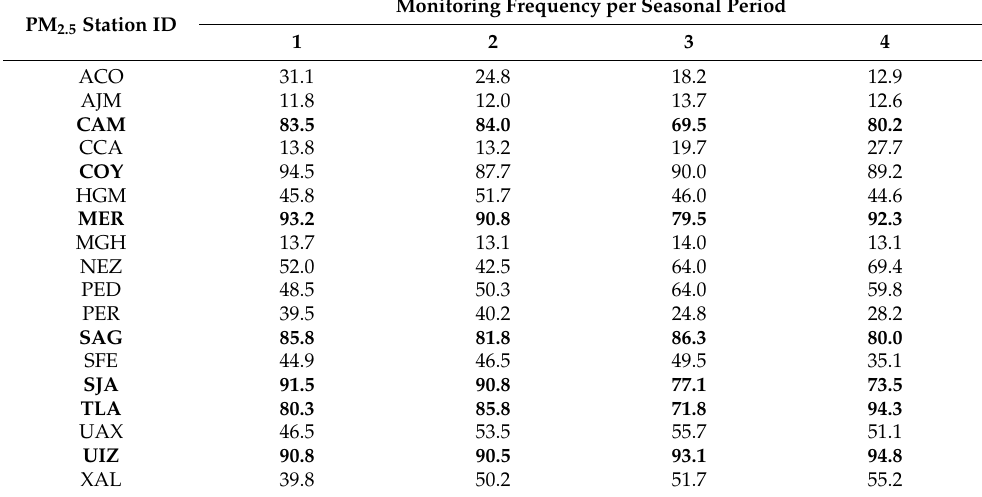
Table A2. Frequency of monitoring days by season for PM 2.5 monitors in the Mexico City Metropoli- tan Area, from 2010 to 2015. Frequencies represent the number of valid monitoring days prior to data imputation. Monitors in bold correspond to the monitors used in the primary health analysis for PM 2.5 . A monitoring threshold of 70% per season was used as the cut-point criterion for consideration in the primary health model.